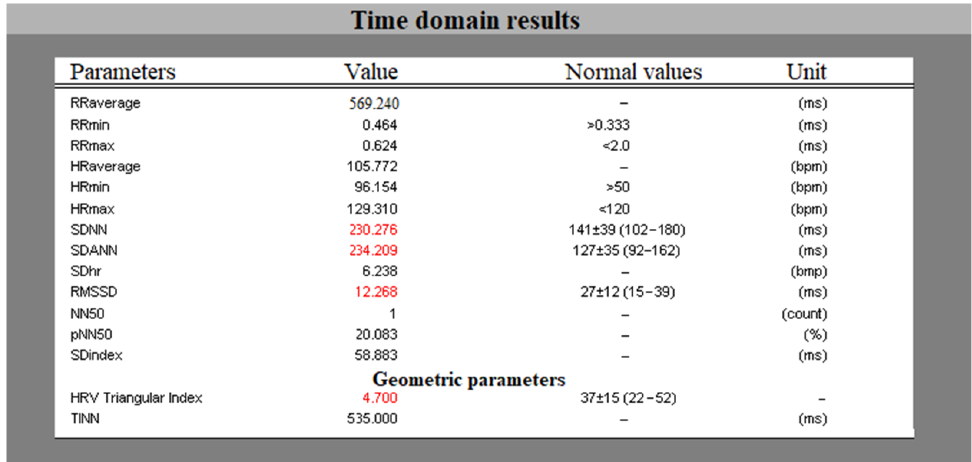
Figure 4. Time domain result field.